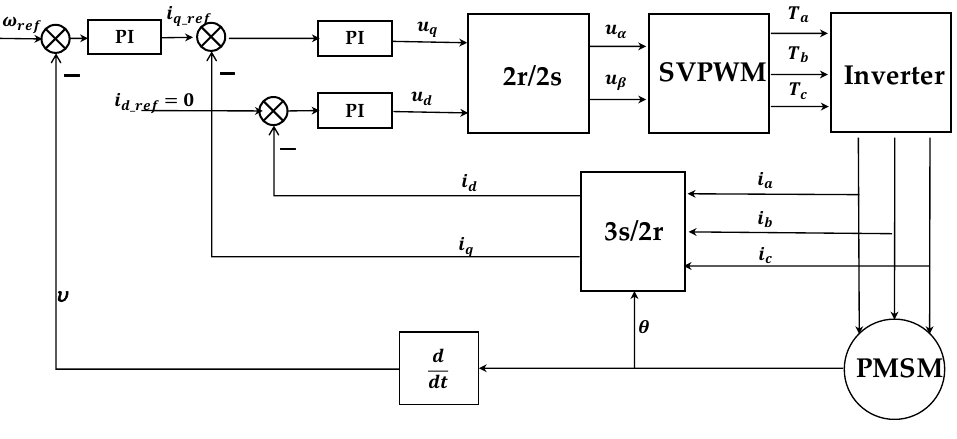
Figure 1. Diagram of FOC vector control system.